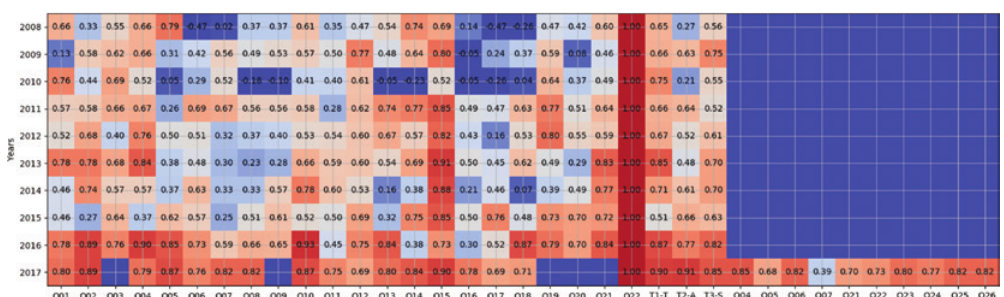
Figure 5: Heat-map of correlations of satisfaction of NSS questions with Q22, in computer science, per year, for Million+ Group providers